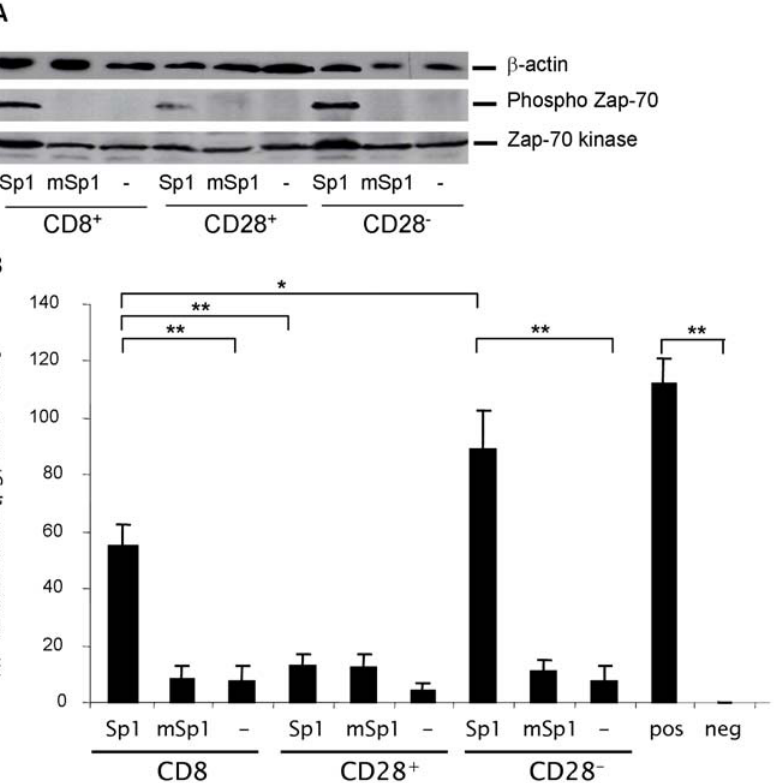
Figure 5. Sp1 induces TCR-mediated activation in CD8 + CD28 2 T lymphocytes. A. Sp1 induces phosphorylation of Zap-70 kinase and total Zap-70 kinase in CD8 + CD28 2 T lymphocytes. CD8 + , CD8 + CD28 2 , and CD8 + CD28 + were incubated in the presence of Sp1, mSp1 (100 m g/ml, respectively), or in medium alone for 4 h. Western blotting was performed with a phospho-Zap-70, Zap-70 kinase-, and a b -actin-specific antibody as a control. A representative blot out of three experiments is shown. B. Sp1 induces NF- k B activity in CD8 + CD28 2 T lymphocytes. CD8 + , CD8 + CD28 2 , and CD8 + CD28 + were incubated in the presence of Sp1, mSp1 (100 m g/ml, respectively), or in medium alone for 2 h. The nuclear extract of treated cells from 4 mice was analyzed by ELISA for NF-kB activity. As a positive control, the nuclear extract from Jurkat cells and as a negative control complete lysis buffer was used. The experiment was repeated three times in an independent manner. Columns indicate the mean NF-kB activity, bars indicate the standard deviation. ** p , 0.001,* p